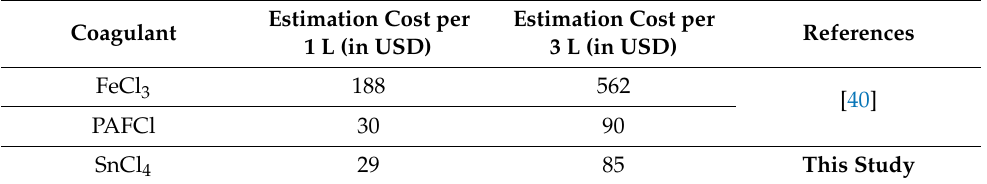
Table 3. Cost estimation between SnCl 4 and other metal coagulants in coagulation-flocculation treatment.